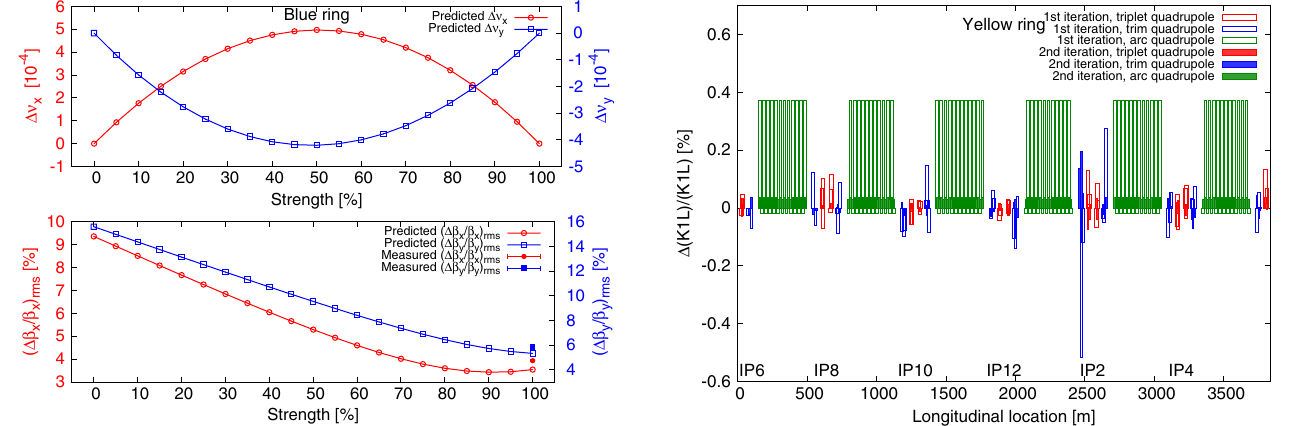
FIG. 5. Relative changes of quadrupole integrated strength as a function of quadrupole locations in the Yellow ring for the first iteration (hollow bars) and second iteration (solid bars), respectively.